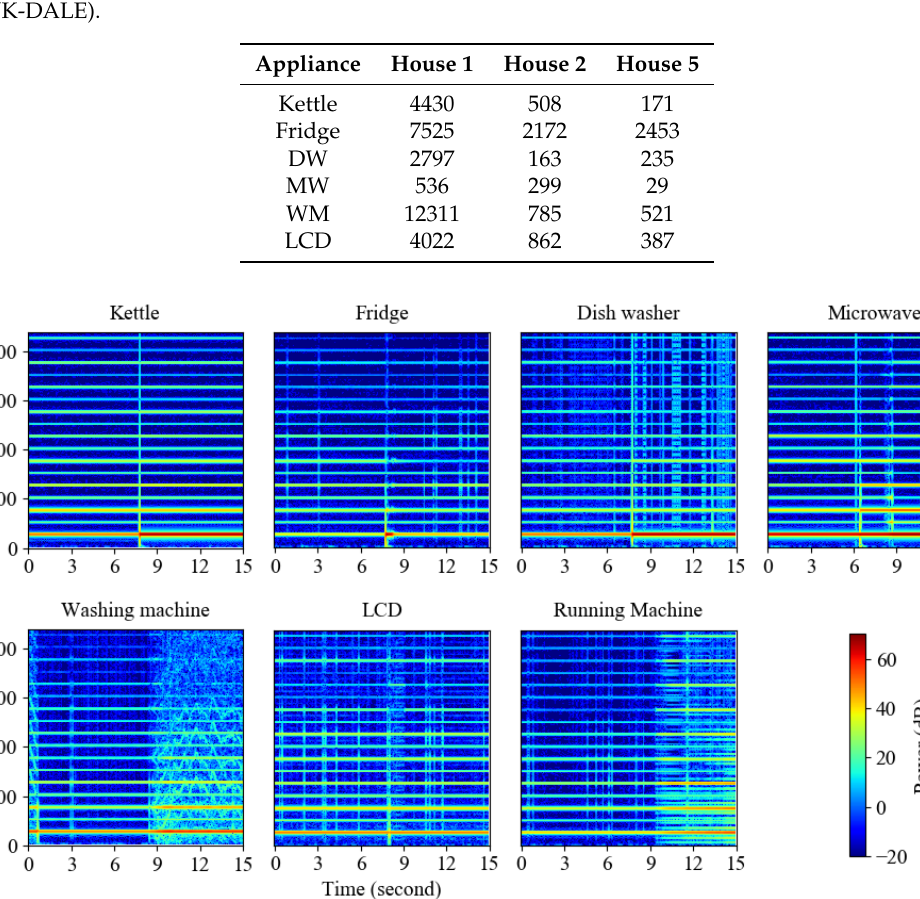
Figure 6. Spectrograms drawn from appliances in UK Domestic Appliance-Level Electricity dataset